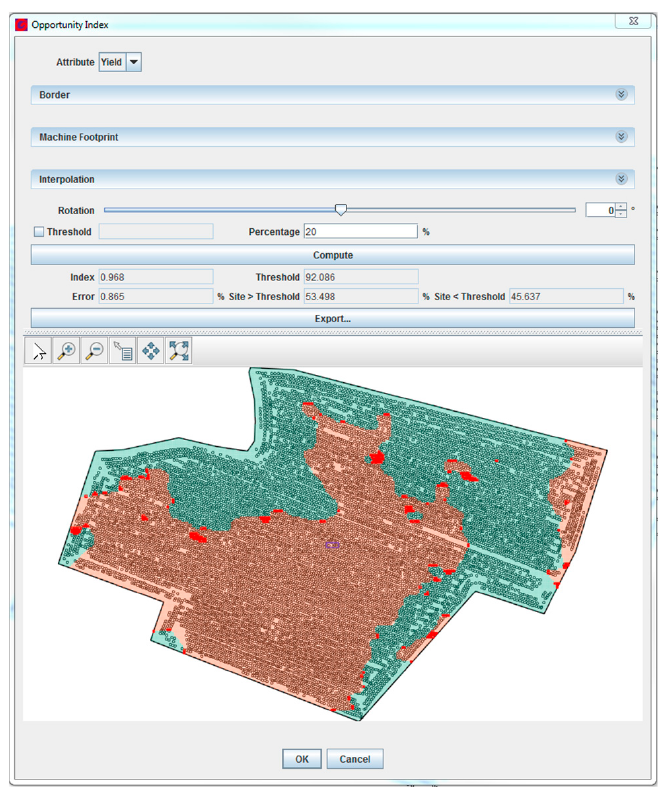
Figure 7. Screenshot of output from the computation of the Technical Opportunity Index (TOI) in GeoFIS for Field 7.